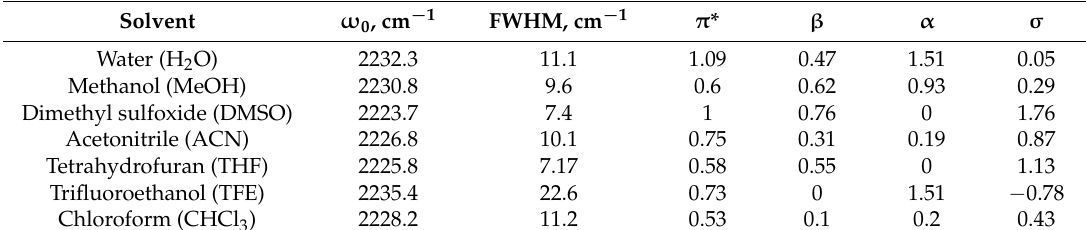
Figure 7. Center frequency of the C ≡ N stretching band of 4-cyanoindole-2 (cid:48) -deoxyribonucleoside (4CNI-NS) versus the solvent σ parameter. The solid line represents the linear regression of these data, yielding a slope of –4.9 cm − 1 and an intercept of 2231.6 cm − 1 . Table 1. The center frequency ( ω 0 ) and full-width at half maximum (FWHM) of the C ≡ N stretching band of 4-cyanoindole-2 (cid:48) -deoxyribonucleoside (4CNI-NS) in different solvents. Also listed for each solvent are its Kamlet–Taft parameters, taken from Ref.